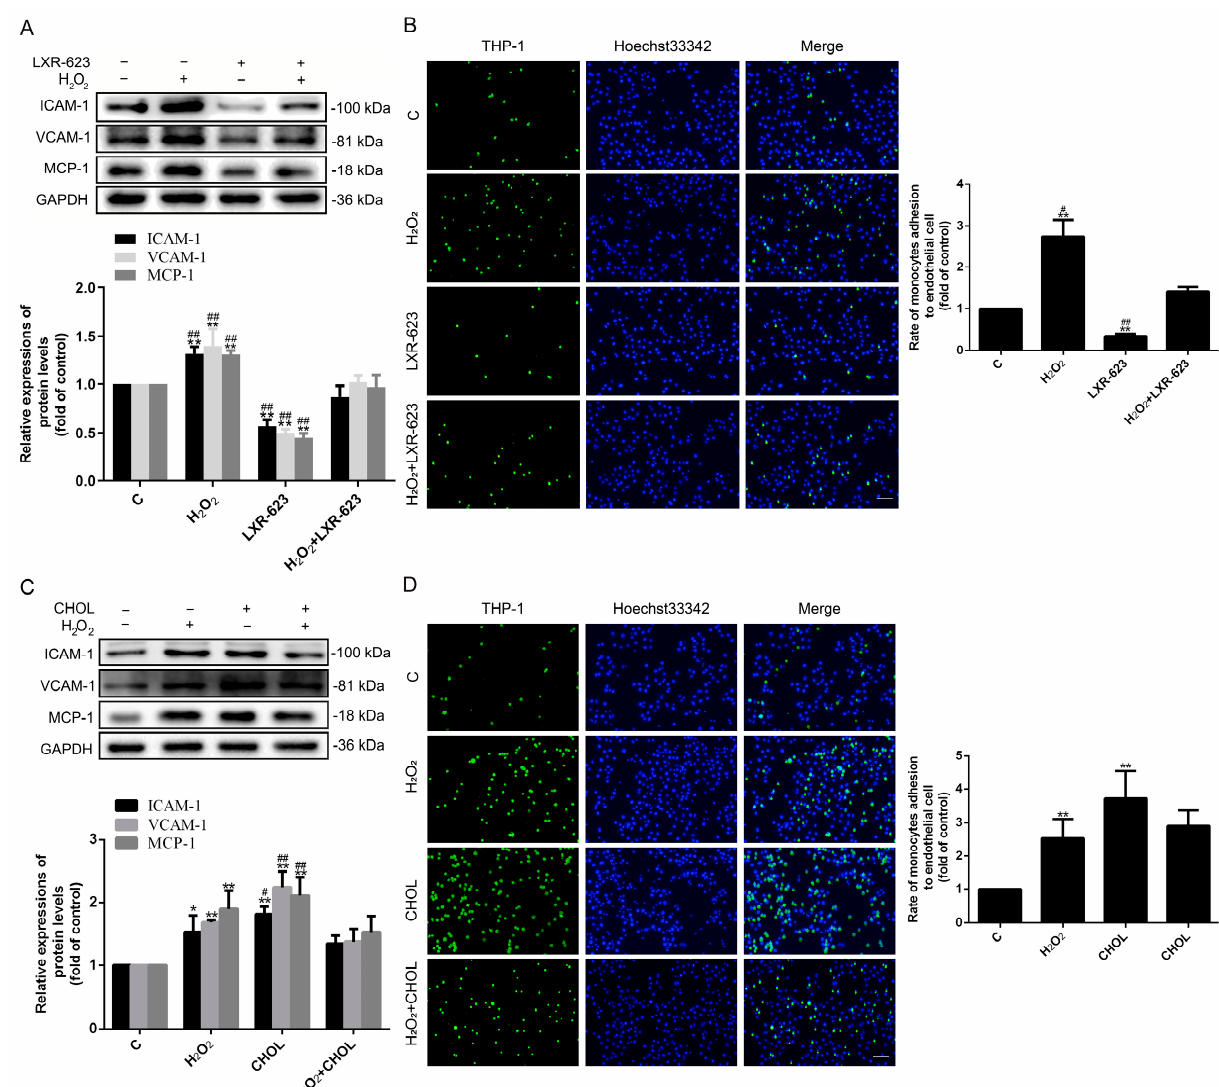
Figure 4. LXR-623 can attenuate the H 2 O 2 -induced adhesion activity of HUVECs by increasing choles- terol efflux, and adding cholesterol extracellularly can augment the adhesion activity of HUVECs by promoting intracellular cholesterol accumulation. ( A , C ) The expressions of ICAM-1, VCAM-1, and MCP-1 were detected by Western blot. ( B , D ) BCFECF/AM (2',7'-Di-(2-carboxyethyl)-5(6)-carboxy fluorescein) was used to label THP-1. The number of THP-1 attached to HUVEC represents the adhesion capacity of HUVEC. Green fluorescence was labeled THP-1 (magnification, 4 × ). n = 3, * p < 0.05 and ** p < 0.001 vs. the C group; # p < 0.05 and ## p < 0.001 vs. the H 2 O 2 + LXR-623 group; # p < 0.05 and ## p < 0.001 vs. the H 2 O 2 + CHOL group. The C (control) group of LXR-623 and cholesterol were treated by DMSO and chloroform, respectively; H 2 O 2 , cells treated with H 2 O 2 (500 µ mol/L) for 24 h; LXR-623, cells treated with LXR-623 (5 µ mol/L) for 24 h; H 2 O 2 + LXR-623, cells treated with LXR-623 (5 µ mol/L) for 2 h and then treated with H 2 O 2 (500 µ mol/L) for 22 h; CHOL, cells were treated by cholesterol (100 µ mol/L) for 24 h; H 2 O 2 + CHOL, cells were firstly treated by cholesterol (100 µ mol/L) for 2 h, and then H 2 O 2 (500 µ mol/L) was used to treat cells for 22 h. The scale of the images is 100 µ